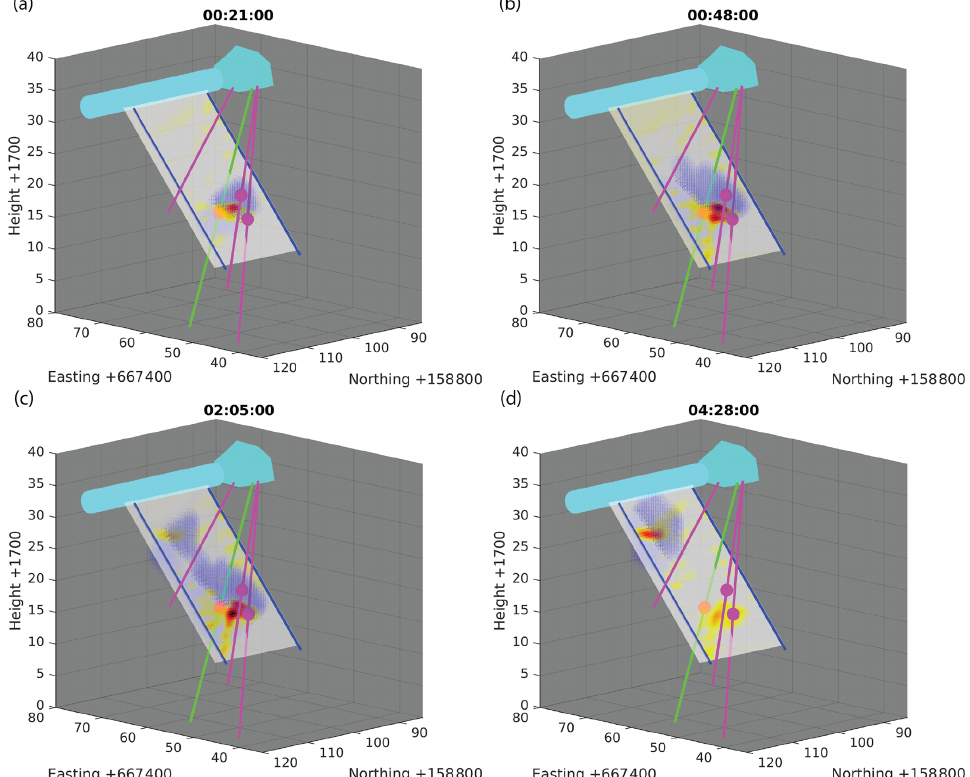
Figure 10. Time-lapse tracer flow path reconstruction with tomography results at different time steps after tracer injection. The reconstructed tracer position is shown in blue, the tomography data are presented with the same color scale as in Fig. 8 with scaled transparency. The injection point lies slightly below the tomography plane. The injection interval is indicated by a red sphere; the two PRP breakthrough locations are indicated by purple spheres.